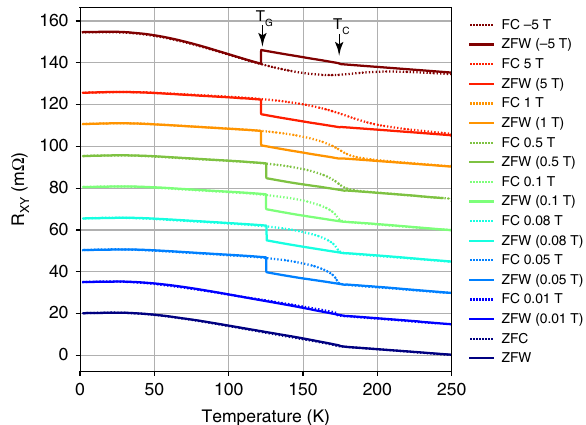
as a function of applied magnetic Fig. 2 Spontaneous exchange bias. R xy fi eld for different low values of cooling fi elds at 2 K. For each fi eld, both a Fig. 3 A transition at 125 K. R xy as function of temperature for zero- fi eld warming (ZFW) up after in- fi eld cooling (FC) of the sample. For each positive sweep protocol (PSP) and a negative sweep protocol (NSP) were cooling in- fi eld (dotted lines) the zero- fi eld warming up (solid) is of the performed, where the sample is warmed up to 250K — well above T C ¼ 175 same color. On the zero- fi eld warming up curves, the transition at 125 K is K — between the two to negate the SEB magnetization effect. The initial fi eld evident as a jump to a different value. For cooling in positive (negative) sweeps for the zero- fi eld cooled curve are marked with arrows, but are fi eld, the jump at 125 K is to a lower (higher) value. The curves for different clear inside the hysteresis loop area for all fi elds. These indicate that the fi elds are shifted vertically for clarity and an easier comparison. initial magnetic state is unsaturated, and that the SEB is indeed induced at the low temperature, by the speci fi cs of the fi eld sweep protocol. The curves for different cooling fi elds are shifted vertically for clarity and an easier